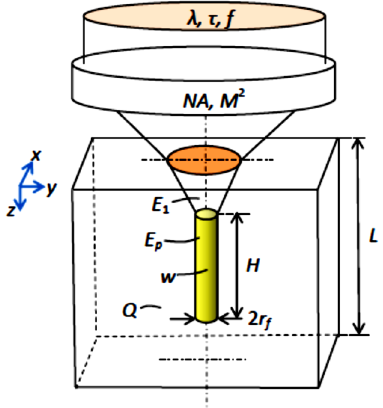
Figure 2. The follow-up to the Figure 1, where other parameters of the model are explained. An individual filament for the sake of simplicity is considered as a cylinder of initial radius r f (at the 1/e-level) and a length H >> r f , with a volumetric energy density w uniform along the length, E 1 is the laser pulse energy inside the material, E p is the energy of the filament plasma, Q is the heat released in the surrounding filament material as a result of relaxation of the filament plasma.